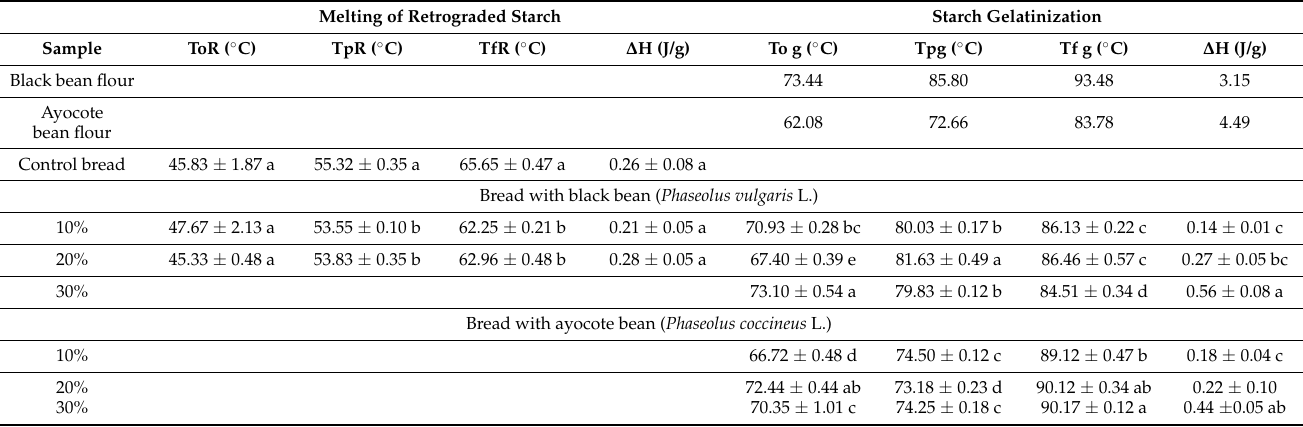
Table 3. Retrogradation and gelatinization properties of black bean (BB), ayocote bean (AB), and breads by DSC analysis *. Melting of Retrograded Starch Starch Gelatinization